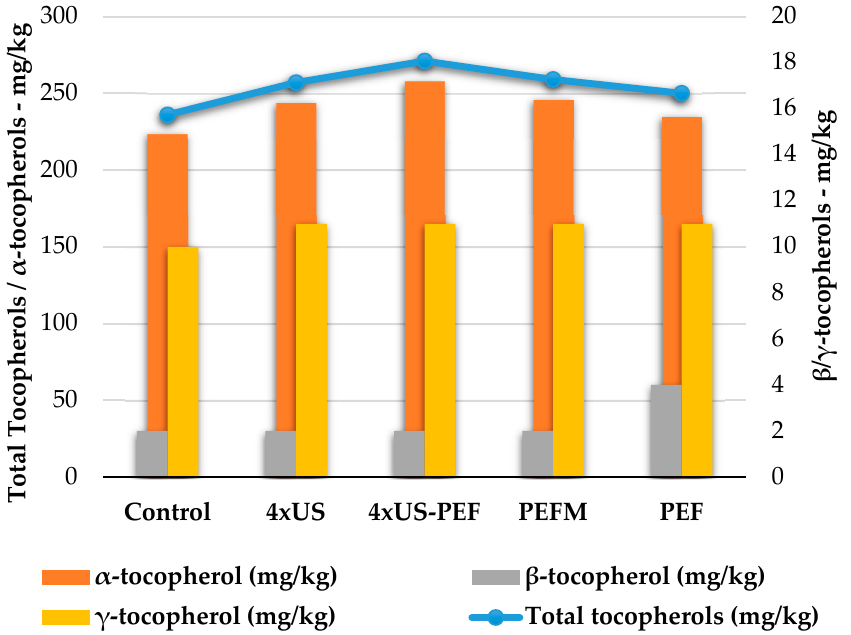
Figure 6. Tocopherol content in oil samples obtained from half-ripe Coratina olives according to processing technology (mg/kg).